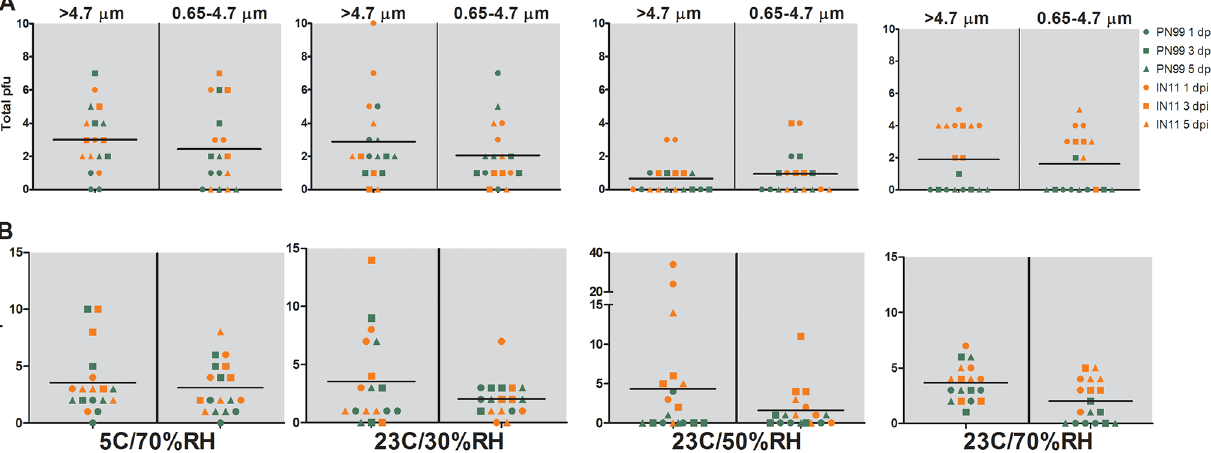
Fig 5. Influenza virus detection in aerosol samples exhaled by infected ferrets. Three ferrets each were housed under the designated environmental conditions and were presented with 10 3.8 – 10 5.5 pfu of PN99 (green) or IN11 (orange) virus by aerosol inhalation. On 1, 3 and 5 dpi, aerosol samples were collected from ferrets for 15 minutes of normal breathing (A) and 5 minutes of sneezing stimulation (B) and were segregated based on size (0.65 – 4.7 μ m or > 4.7 μ m) and then assayed for the presence of infectious influenza virus. Total plaque forming units (pfu) from individual ferrets, n = 3, is shown with the grand mean for each sampling